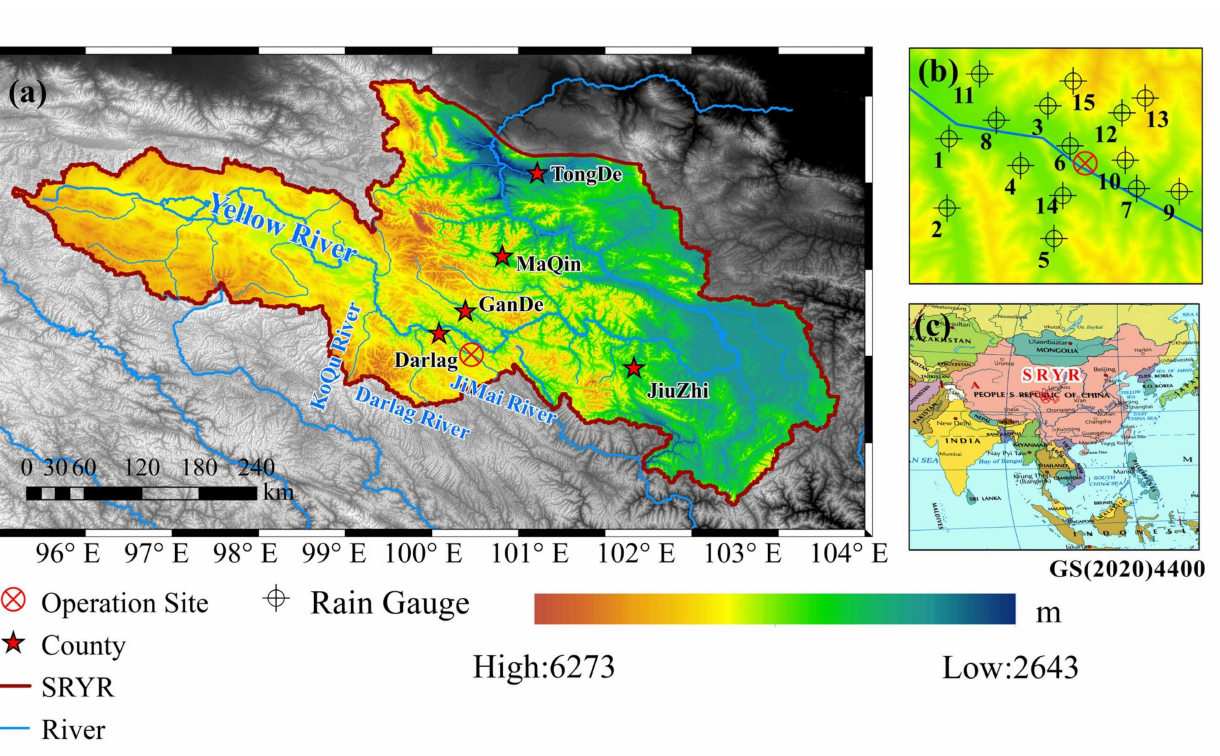
Figure 1. Geographic location of acoustic interference experiments in the SRYR ( a ) and distribution of rain gauges near the field site ( b ), and the location of SRYR in the world ( c ). The sound generator and monitoring devices at the field site were arranged in a zigzag pattern, covering an experimental area of approximately 300 m 2 . The site has four sound generators, a Ku-Ka dual-band weather radar instrument, a wind profile radar (WPR) instrument, a microwave radiometer (MWR), a micro-rain radar (MRR) instrument, a white weather station, three disdrometers (OTT), and 15 rain gauges (RGs, Figure 1c). The locations of these rain gauges (within a 5 km radius of the operation site) are presented in Figure 1. The observation system was constructed to monitor weather conditions, cloud motions, raindrop microphysical structures, and rainfall distributions. There are several Global Navigation Satellite System (GNSS) receiving stations near the operation area for local, real-time, high-resolution monitoring of airborne water